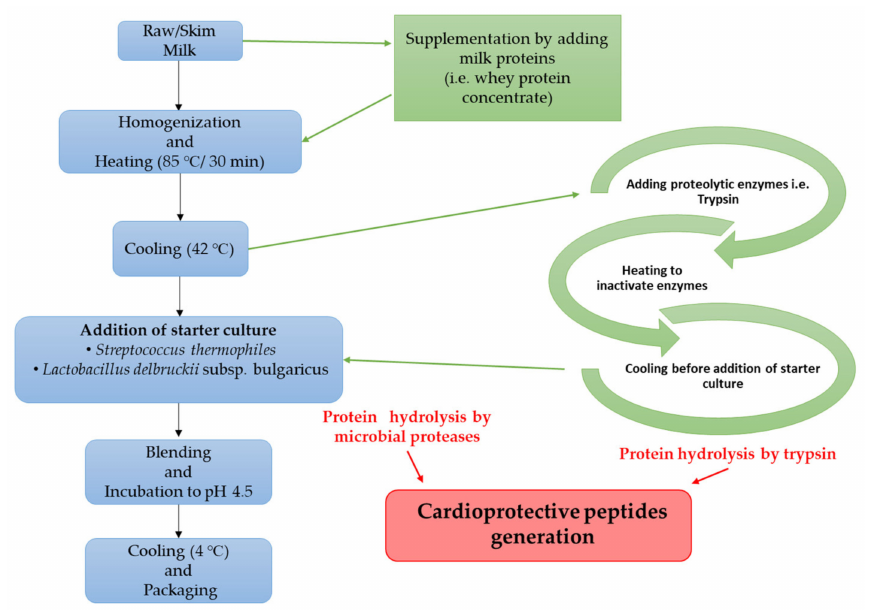
Figure 2. Generation of cardioprotective peptides during yogurt production process.